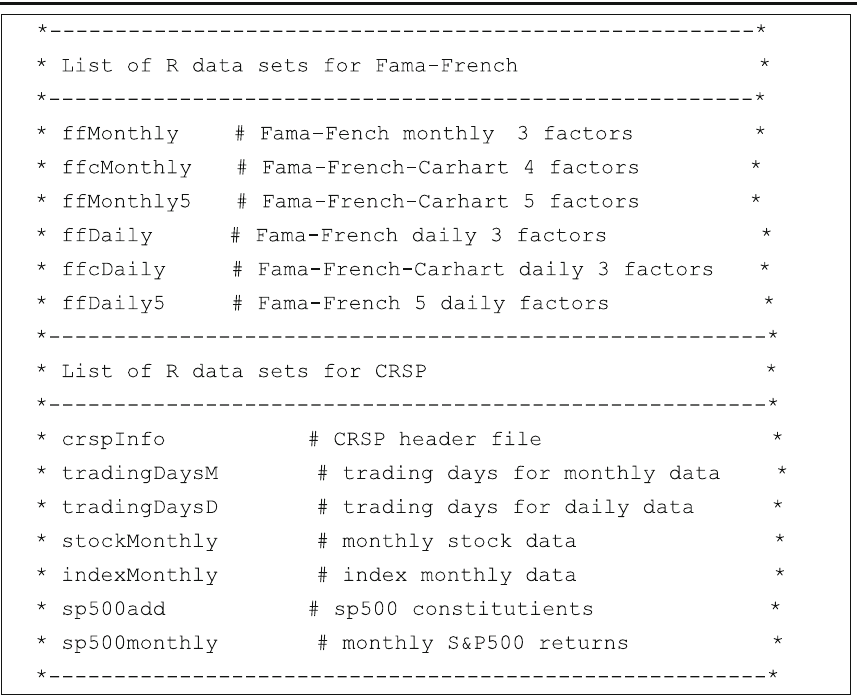
Table 4 A partial list of R data sets related to term